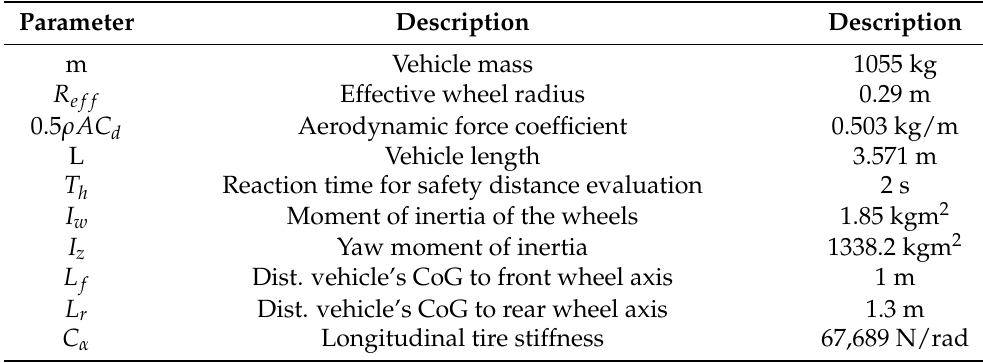
Table 1. Parameters of the ego-vehicle